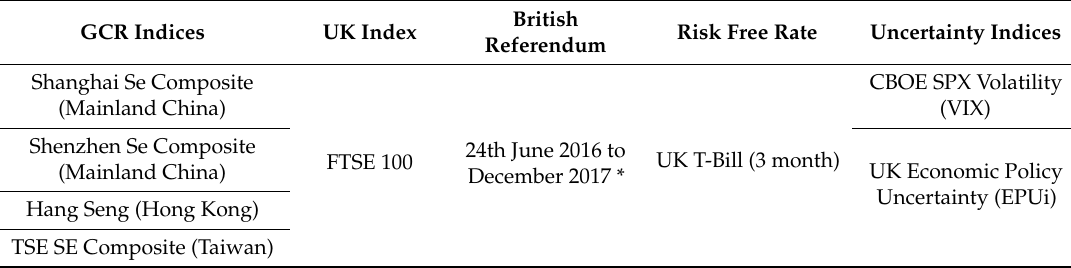
Table 1. Research Sample June 2015 to December 2017.